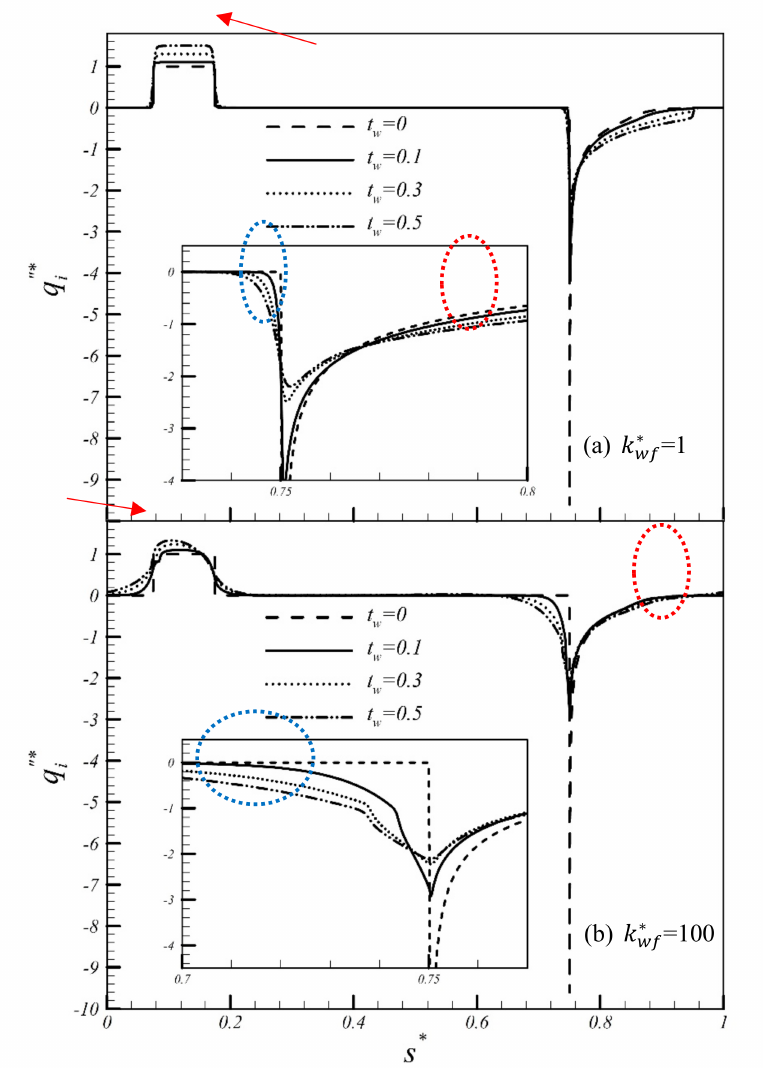
Figure 6. E ff ect of wall thickness t w on distribution of local dimensionless heat flux q ” ∗